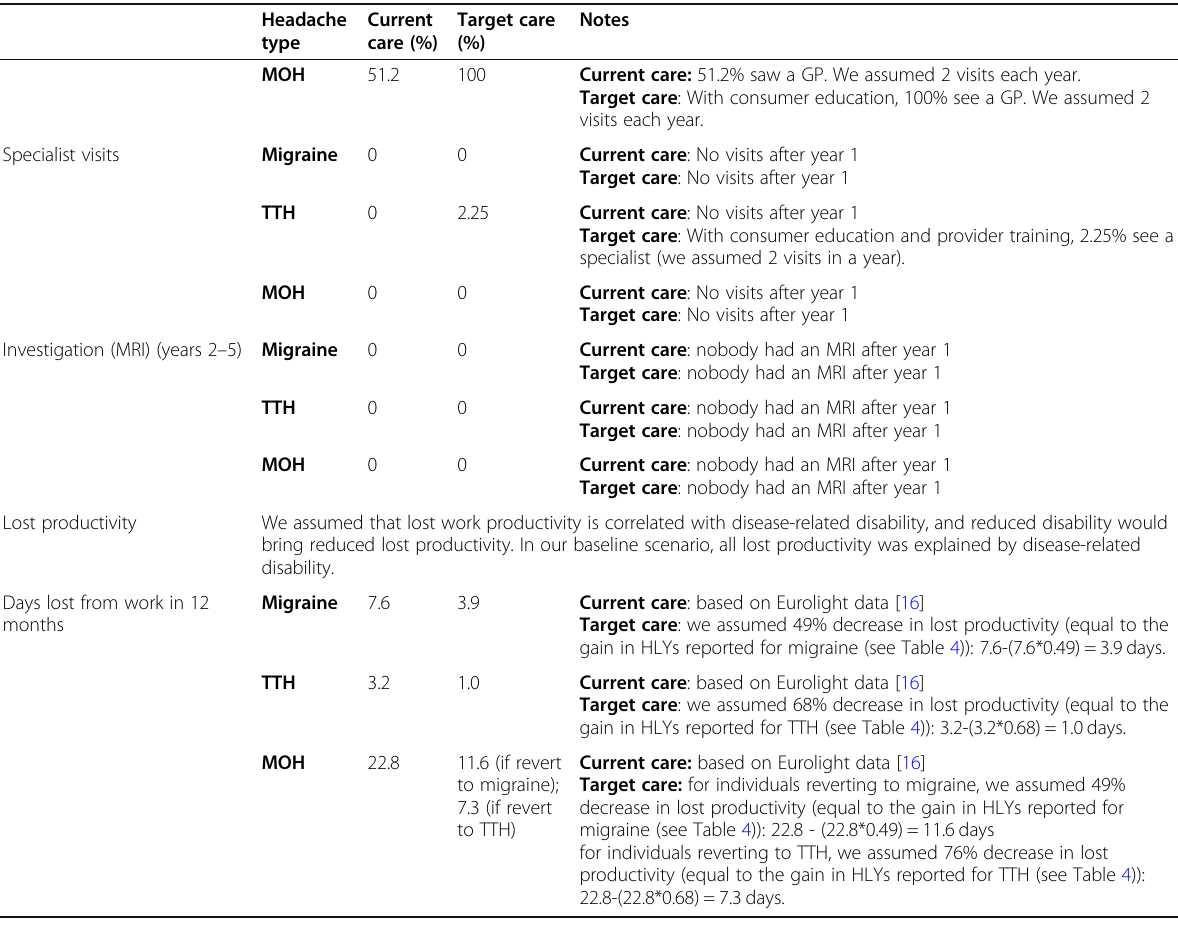
Table 2 Treatment uptake, use of resources and lost productivity according to treatment management plan (Russia)